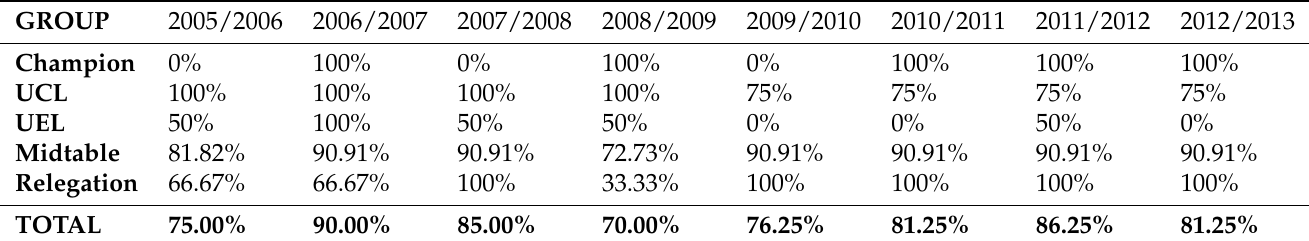
Table 3. Comparison of hits of Algorithm 1 with respect to the actual results of of seasons